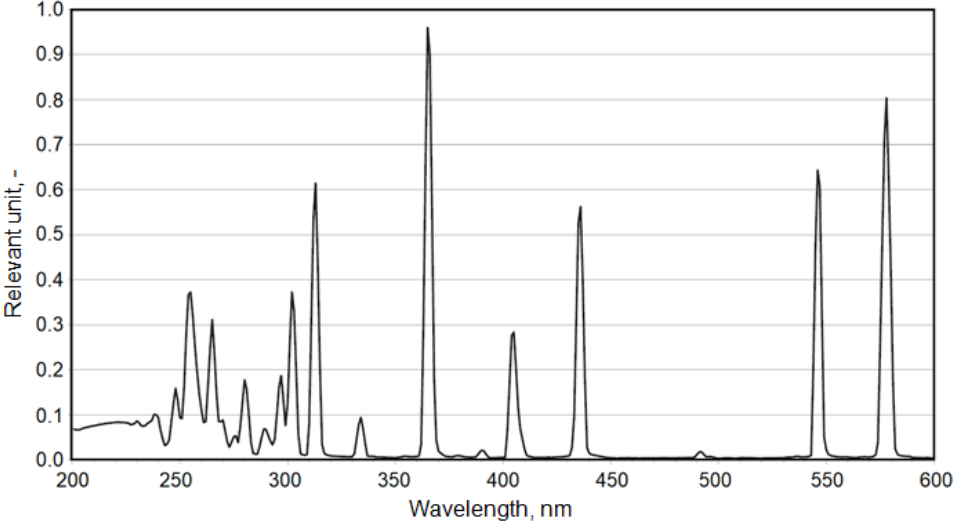
Figure 14. Characteristic of radiation wavelengths emitted by the used UV lamp (Data achieved from the supplier of Heraeus UV lamp reactors KENDROLAB Sp. z o.o.). Table 5. Energy values of individual wavelengths emitted by the UV lamp.